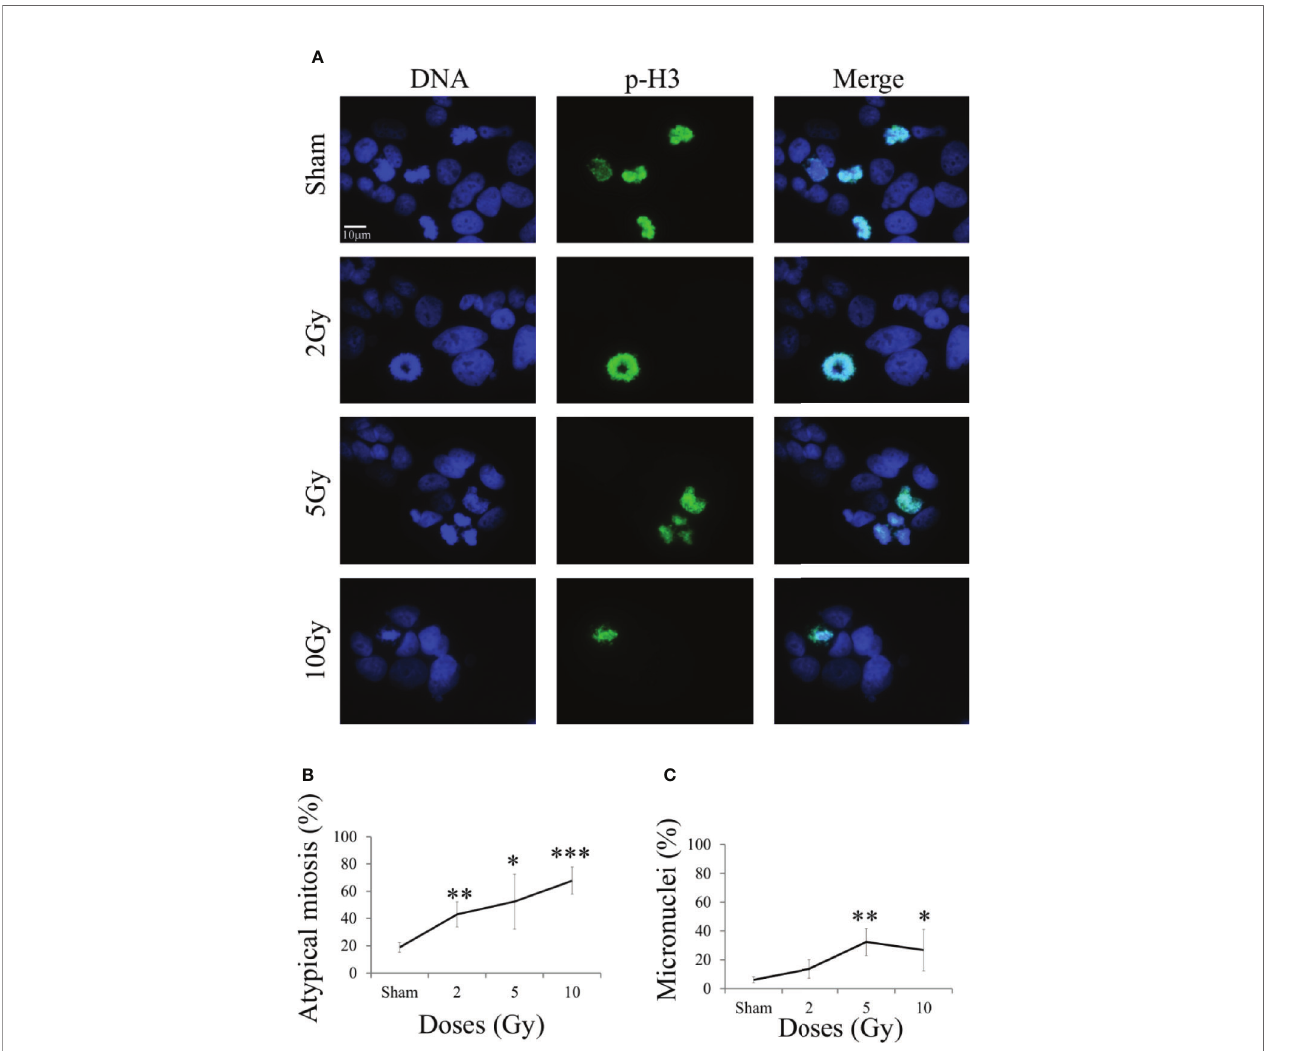
FIGURE 7 | Mitotic instability markers with fl uorescence microscopy. For Caco-2 cells 48 h after X-ray exposure following the “ Treat + Seed ” protocol: (A) Illustrative fl uorescence microscopy images (scale bar: 10 m m) for the different irradiation conditions, obtained with Hoechst (for nuclear DNA, left) and pH3 (as a speci fi c mitotic marker, center) staining and their merge (right), used to identify micronucleated cells and cells presenting mitotic atypia ( e.g. anaphase bridges, multipolar, ring, dispersed, asymmetrical, lag-type mitoses); (B) Percentage of atypical mitoses (normalized to all analyzed mitotic cells) as a function of X-ray dose (line is a guide to the eye); (C) Percentage of micronucleated cells (normalized to all analyzed cells) as a function of X-ray dose (line is a guide to the eye). Data are mean ± SD, obtained from ≥ 3 independent experiments. Statistical signi fi cance (Student ’ s t-test) is as follows: *p < 0.05, **p < 0.01, ***p <